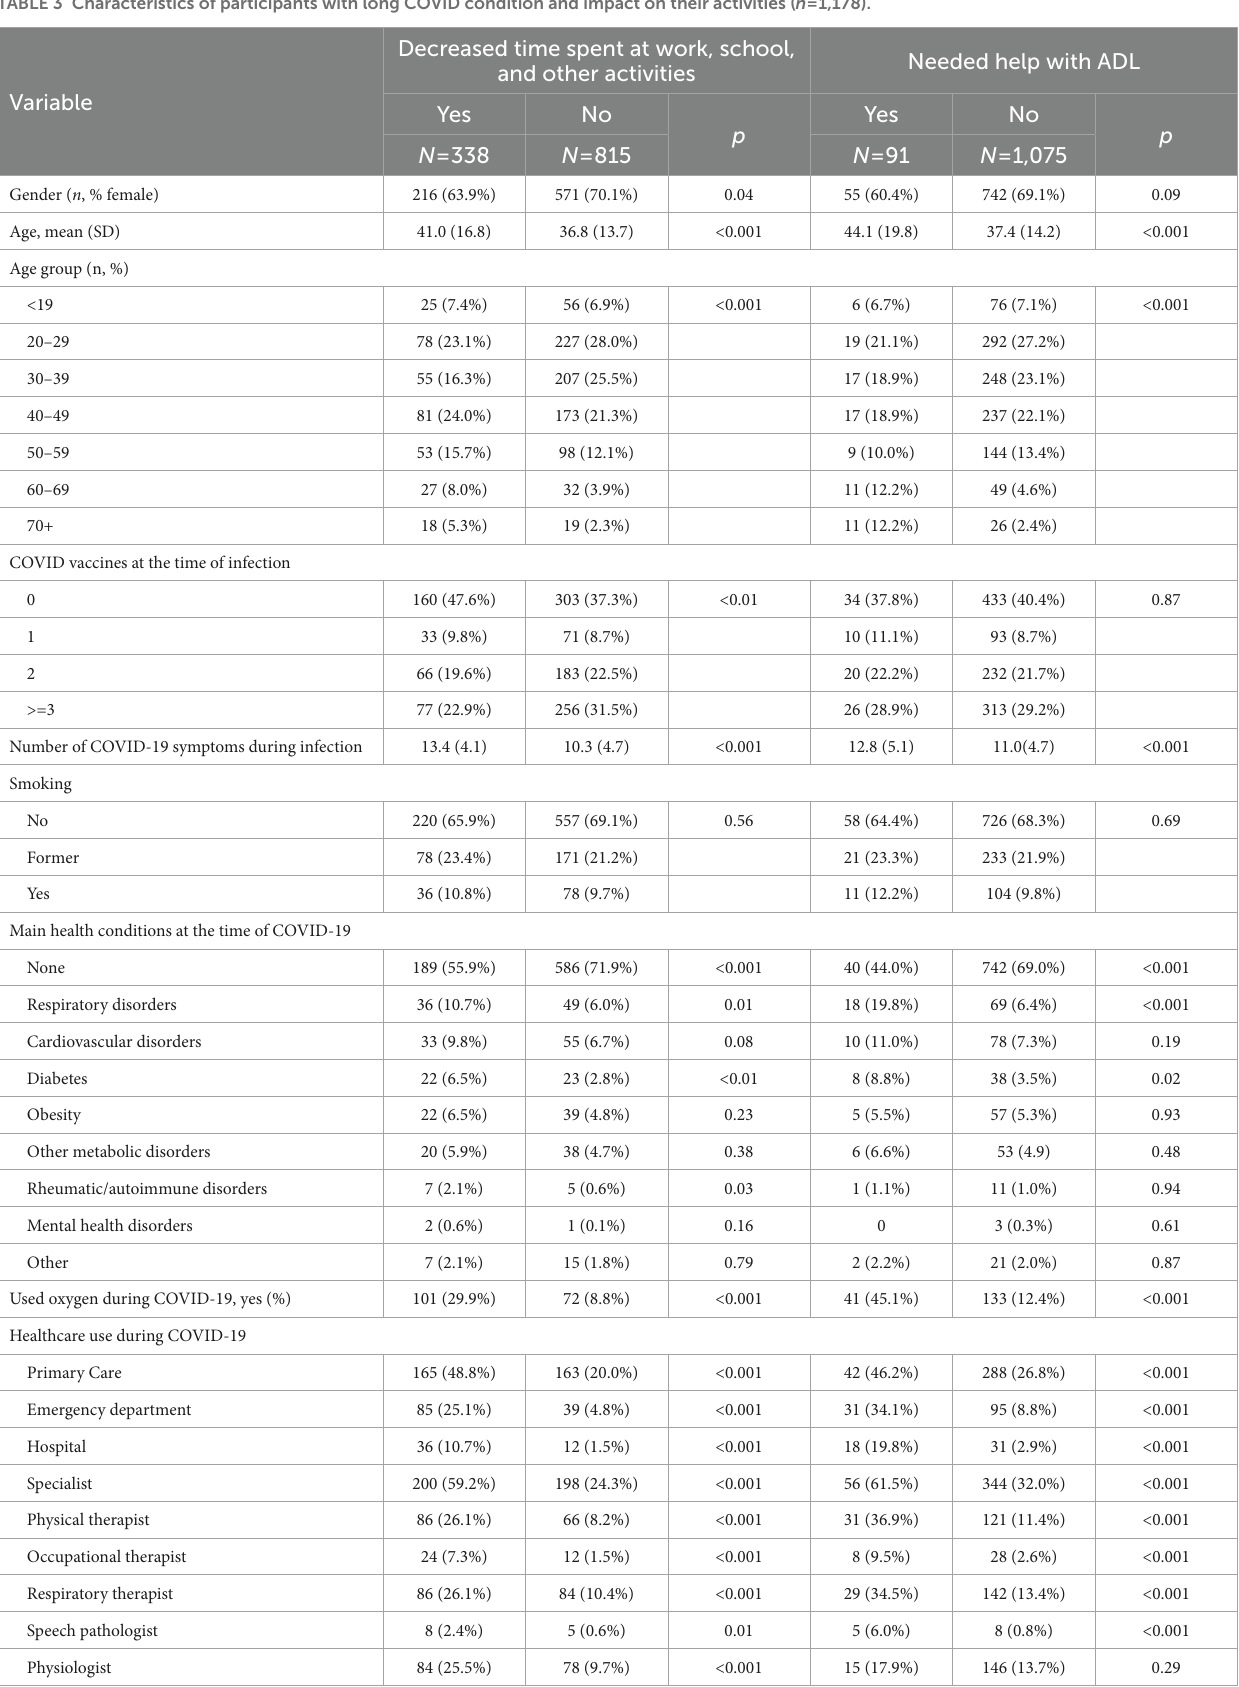
Needed help with